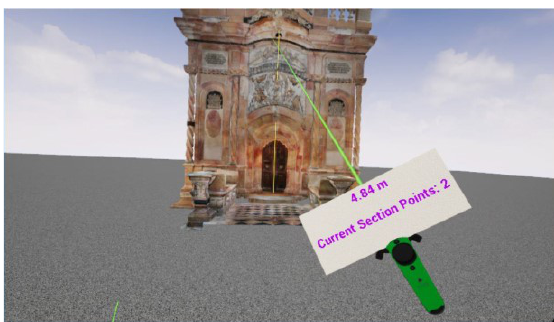
Figure 9. The virtual environment of the final